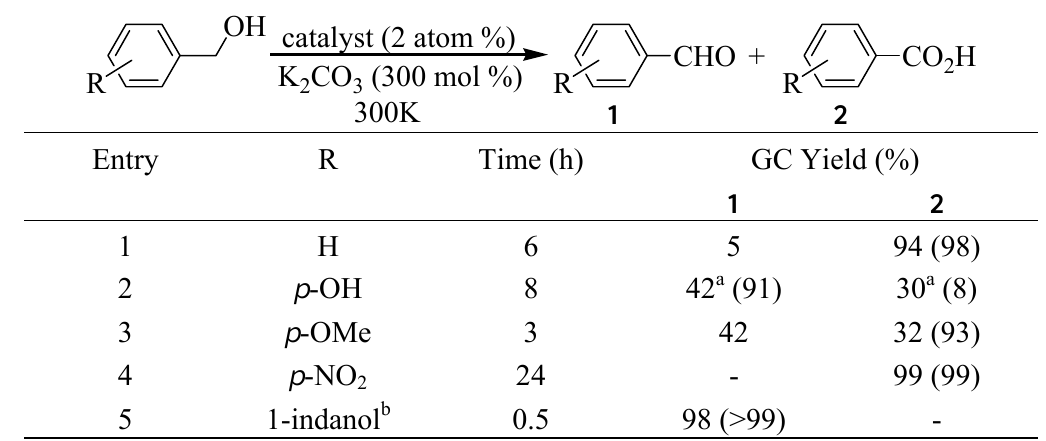
Table 1. Aerobic alcohol oxidation of various benzyl alcohols by Fe in parentheses correspond to those for the established Au:PVP catalyst